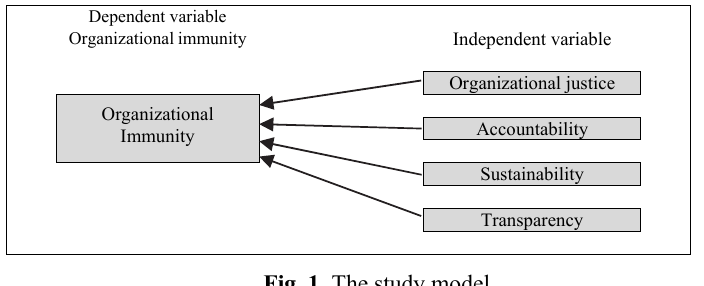
Fig. 1. The study